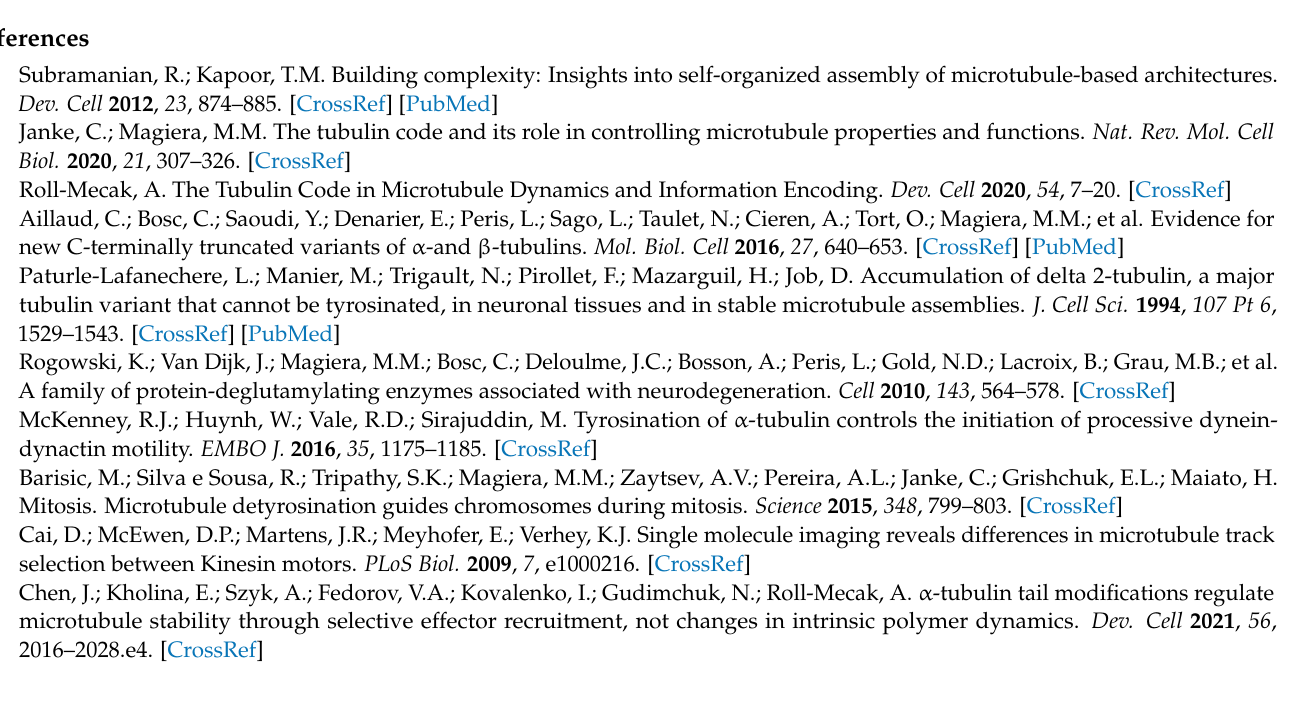
Figure S5: Expression levels of CCP genes in various tissues; Figure S6: Immunofluorescence staining of TTL ∆ CCP1 ∆ cells undergoing cytokinesis; Figure S7: Transient expression of CCP1 mutant in HeLa, HK293T, and CHL-1 cells; Figure S8: Immunofluorescence images of ∆ Y- α -tubulin in HeLa cells expressing VASH1-SVBP; Figure S9: ∆ Y- α -tubulin staining is not changed in the photoreceptor axoneme of ccp1 − / − mouse retinas; Figure S10: Expression levels of CCPs in photoreceptor neurons at the indicated days of post-natal development; Table S1: Oligonucleotide DNA primers used in this